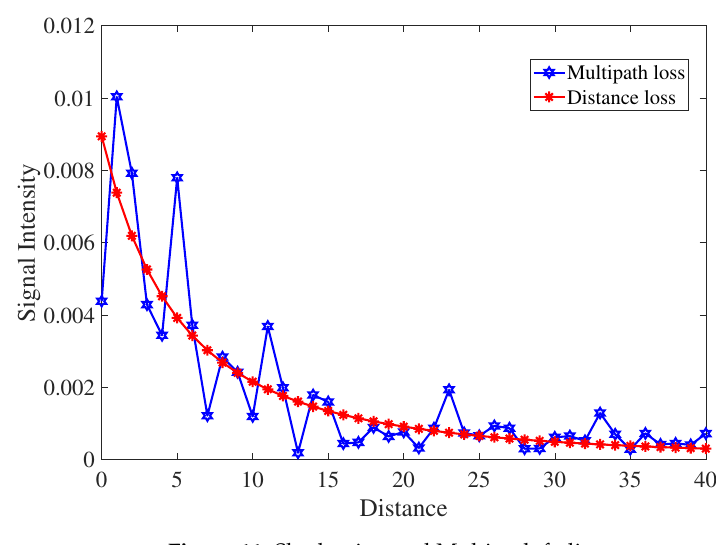
Figure 11. Shadowing and Multipath